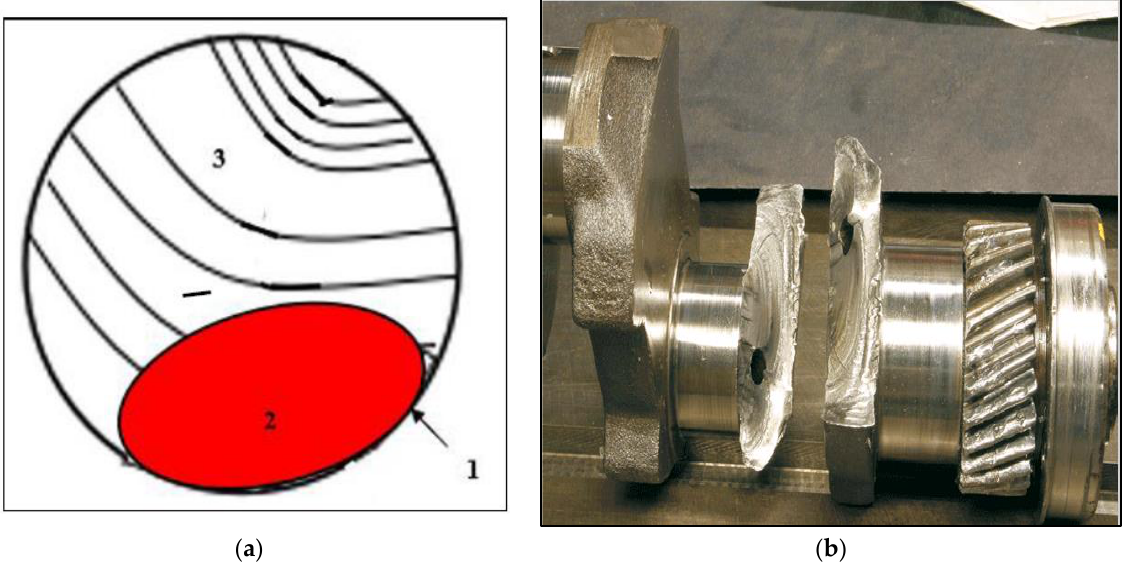
Figure 18. ( a ) The proposed model of fracture by Yang et al. [44], and ( b ) fracture of a steel gearbox.